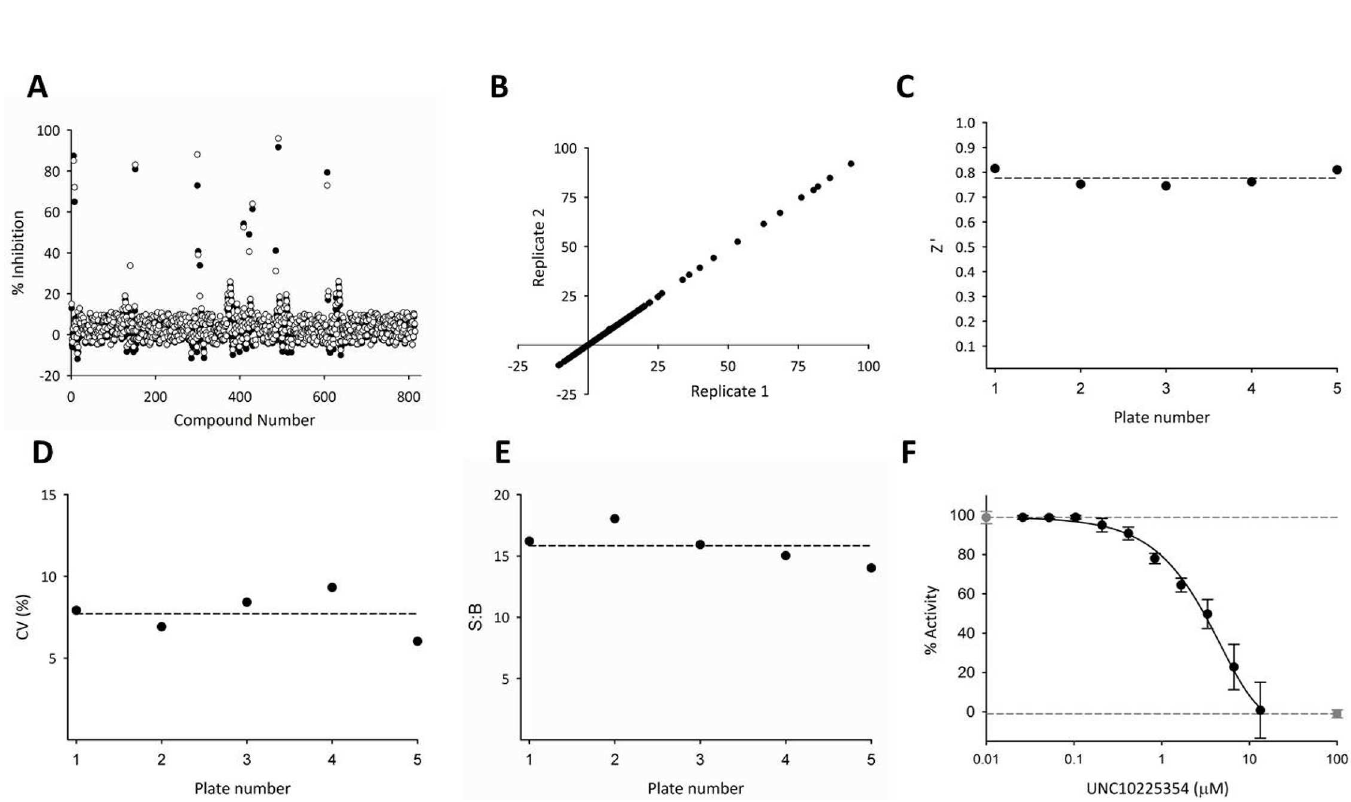
Fig 2. Application of the PKIS library to judge performanceof the HTS assay. (A) Representative technicalreplicates measuredon the same day. (B) Comparison of the mean values of biologicalreplicates (black and white circles) obtained on two different days. R 2 = 0.98. (C) Z’ Factor (0.78 ± 0.03) (D) % CV (7.5 ± 1.6) (E) Signal:background ratio (15.8 ± 1.5) (F) These plates included negative controls (DMSO; gray circles, broken line and positive controls (100 μ M UNC10225354; gray square, broken line). Each plate also containedone 10-point titration for UNC10225354; data (black circles) depict means